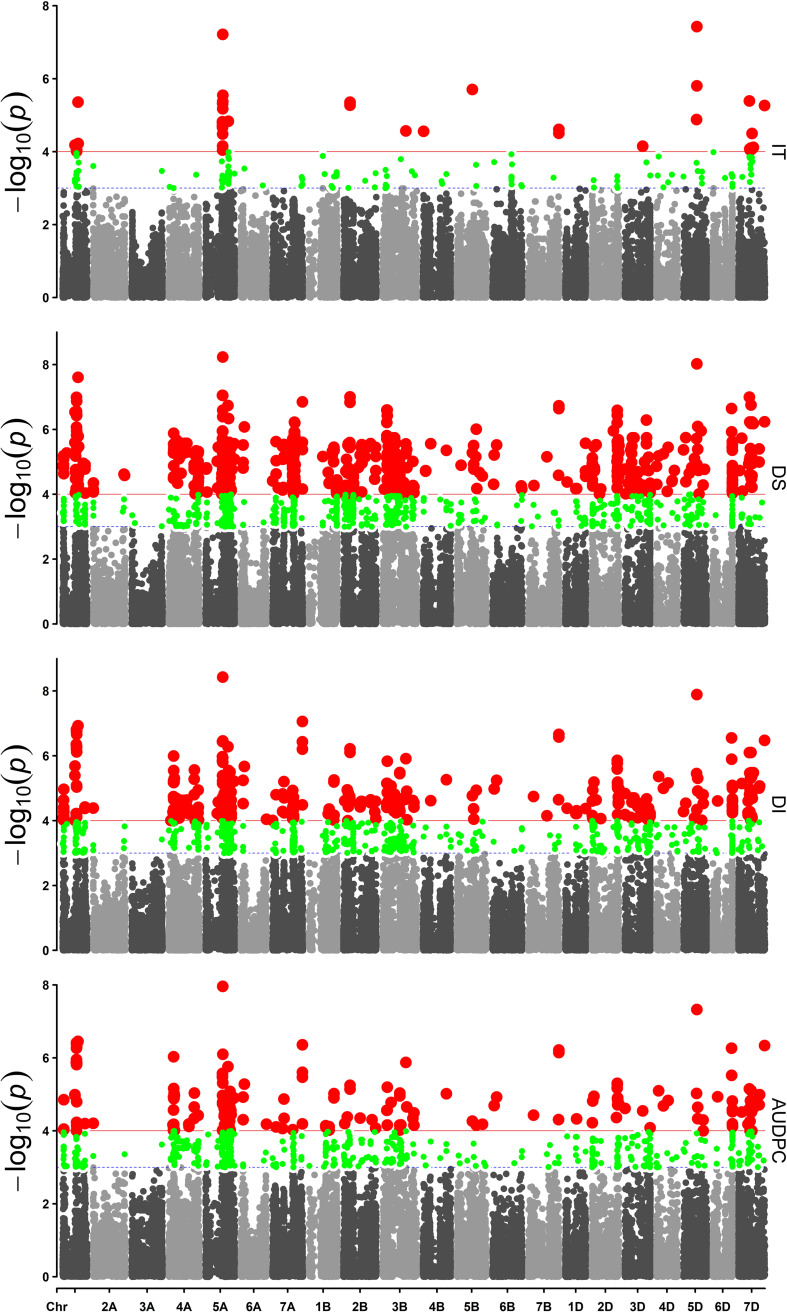
Manhattan plots of the markers associated with IT, DS, DI, and AUDPC in 19WJ. Red points above the red lines were considered as the significant associated locus where P < 0.0001. Green points between the red lines and blue dashed lines were markers with P < 0.001.